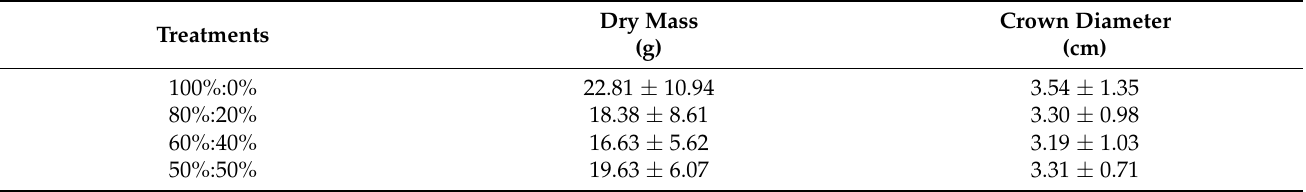
Table 4. Total dry mass and crown diameter of mother plants of four treatments. The mother plants were measured at the end of the experiment. Crown diameter is presented as the average of narrow and wide measurements. Data are presented as the mean ± standard deviation ( n = 10). No significant differences were detected between treatments.